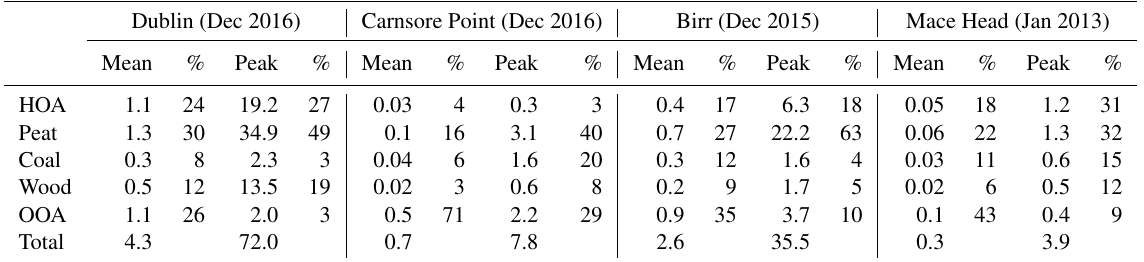
Table 2. Average and peak concentrations of HOA, peat, coal, wood, and oxygenated organic aerosol (OOA), as well as their relative contribution (%) to the total OA mass at the four measurement sites across